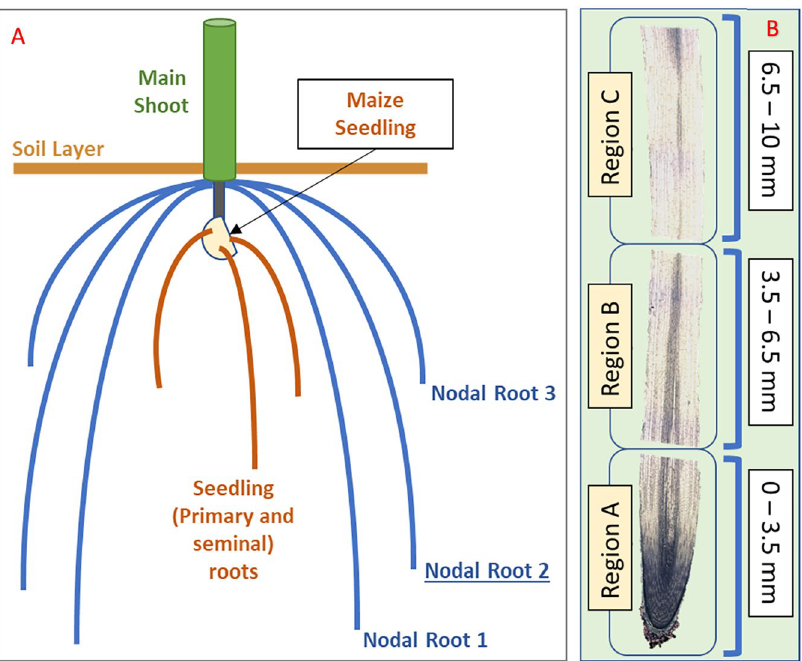
Figure 1. ( A ) Schematic diagram showing root growth in first 16 days after maize seedling germination, including the emergence of the primary and seminal roots, along with the first 3 Nodal roots. The first 10 mm tip of the nodal root 2 was collected and divided into 3 sections for RNA-seq library generation. ( B ) Maize nodal root no.2’s tip structure, divided into three sections: Region A, 0–3.5 mm; Region B, 3.5–6.5 mm; Region C, 6.5–10.5